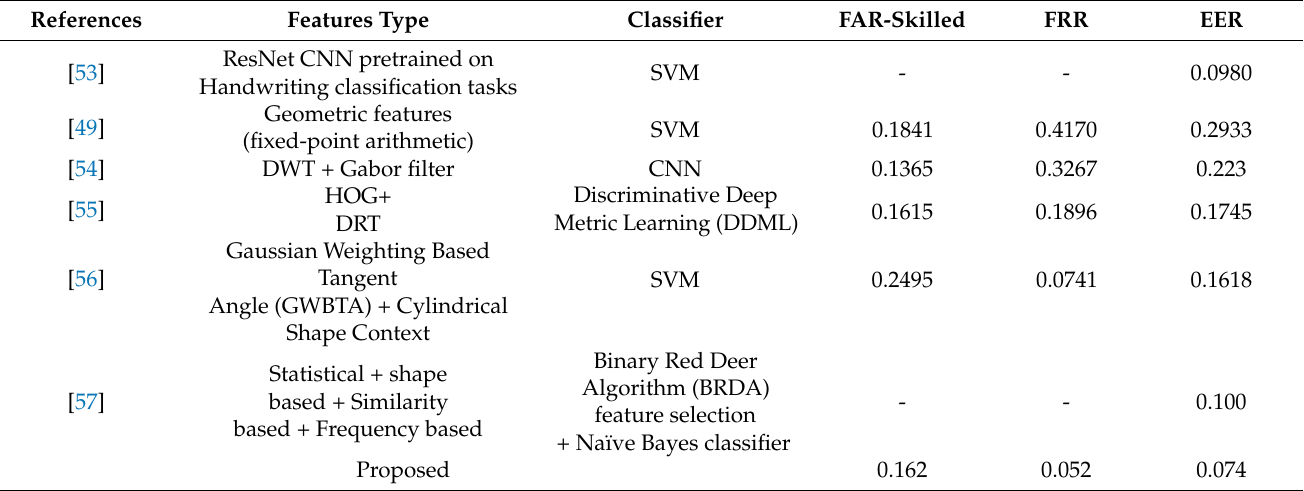
Table 11. Comparison of the results of the proposed approach and the state-of-the-art methods using the UTSIG database.